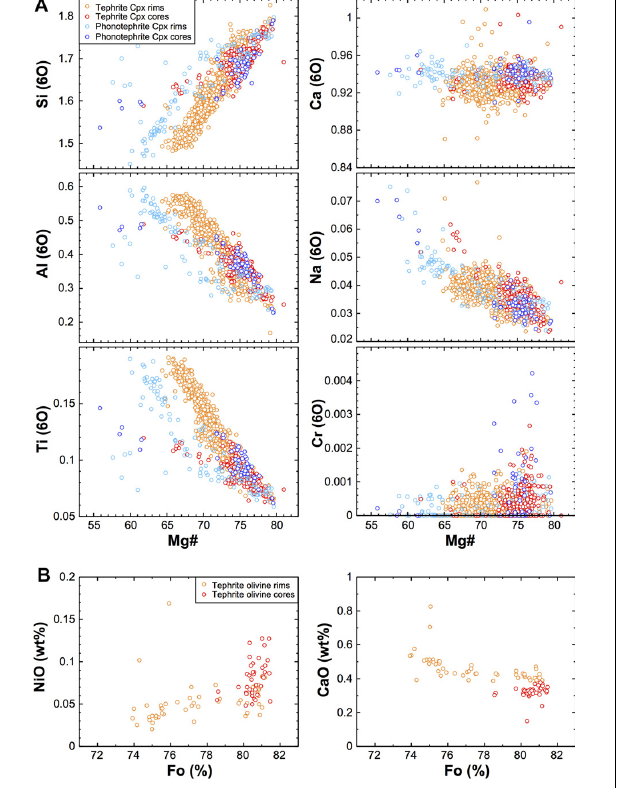
Olivine phenocrysts show little compositional variation. Most cores have nearly constant composition of Fo 80 . 0 − 81 . 5